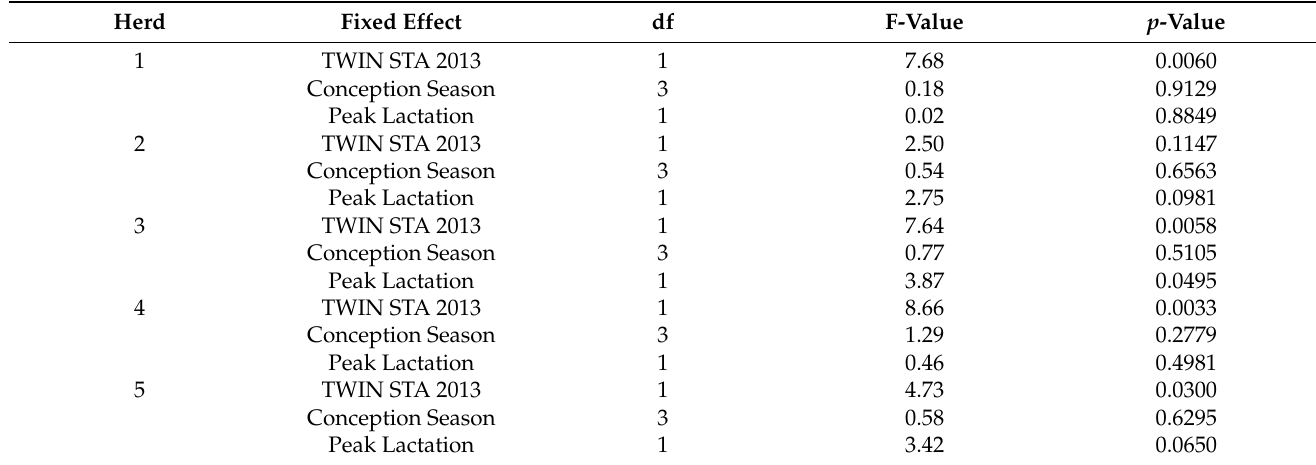
Table 9. Type III Tests of Fixed Effects in the model used for the tertiary analysis on 3rd lactation cows (regressing individual animal TWIN STA on twinning incidence), degrees of freedom, F-value and associated p -value. Fixed effects of TWIN STA, season of conception and peak lactation output from the previous lactation are